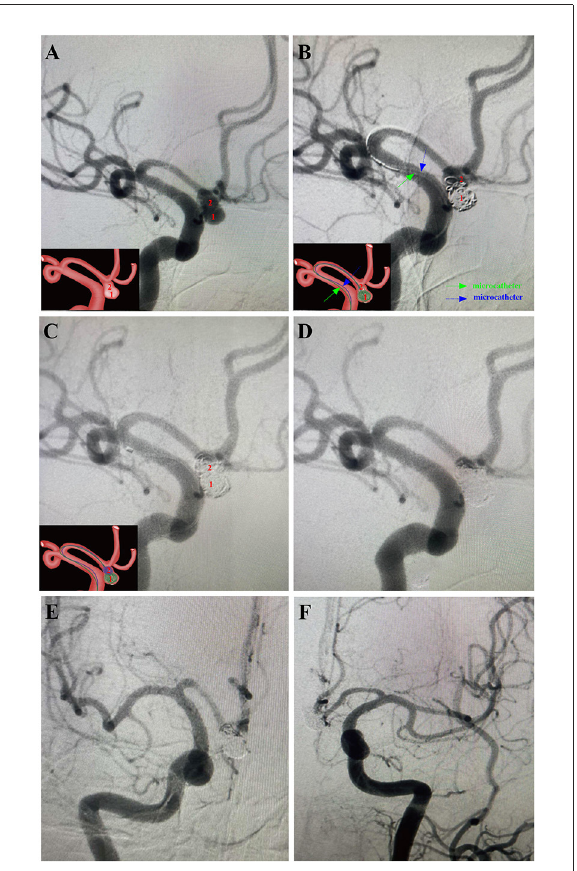
FIGURE2 A 54-year-old male patient with a sudden headache for 7h was admitted into our department with the diagnosis of subarachnoid hemorrhage (Hunt-Hess grade II) arising from ruptured irregular AComA. Then, this aneurysm was successfully treated using the MCP technique in the acute stage. Arabic numerals indicate the ascus of an IA. Right ICA DSA (working angle) demonstrated a gourd-like irregular aneurysm with a daughter sac at the AComA. Double microcatheters were introduced in the IA sac. Embolization was performed with a microcatheter (green arrow) navigating into the lower daughter sac and coils packing. Embolization with coils of appropriate size alternatively through the tips of the two microcatheters until embolism was satisfactory. After packing the lower sac, the upper daughter sac was coiled via the other microcatheter (blue arrow). (D–F) Post-embolization digital subtraction angiograms exhibited occlusion at Raymond grade II. (D) The working angle view of postoperative embolization. (E) The anteroposterior view of the right ICA after postoperative embolization. (F) The anteroposterior view of the left ICA after postoperative embolization. The inserts in the lower right corner illustrated an aschematic diagram of the MCP process of the IA (A–C)